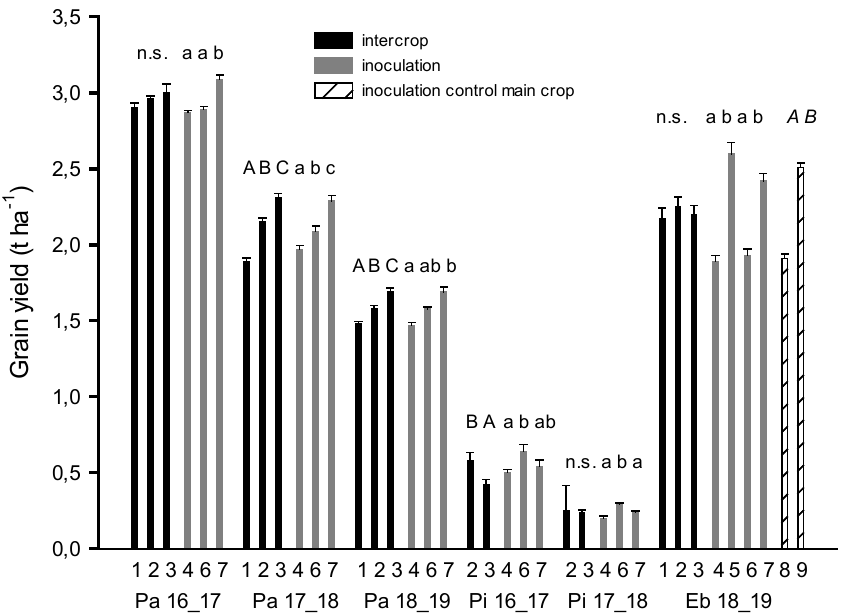
Figure 4. Grain yield (t ha −1 ) for soybean main crop. For explanations, see Figure 1. Italic capital letters indicate significant differences between the inoculation variant of the main crop. 8 = without inoculation main crop; 9 = with inoculation main crop; n.s. = not significant.